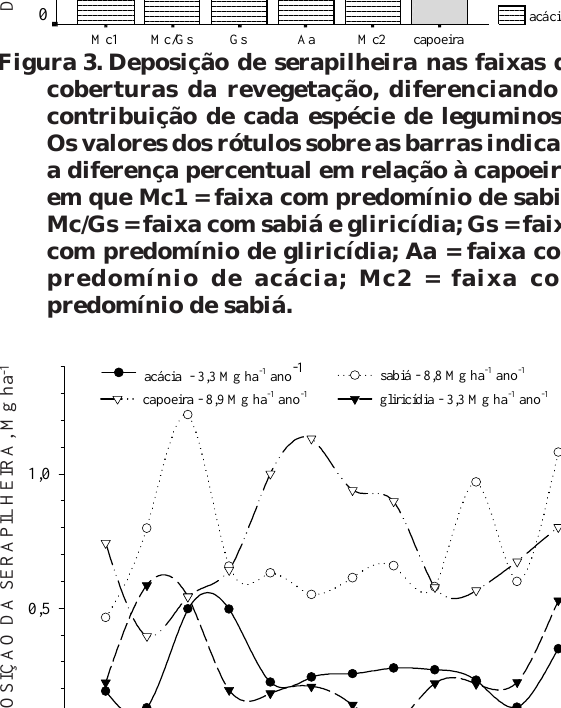
Figura 4. Variação anual da deposição de sera- pilheira de cada espécie de leguminosa utiliza- da na revegetação, incluindo a capoeira. Na revegetação, os valores são referentes às faixas com predomínio de uma espécie de leguminosa, sendo considerada somente sua deposição.